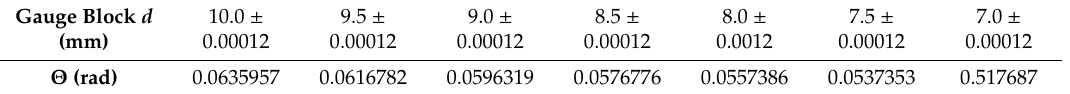
Table 6. Experimental results for standard gauge block measurement.